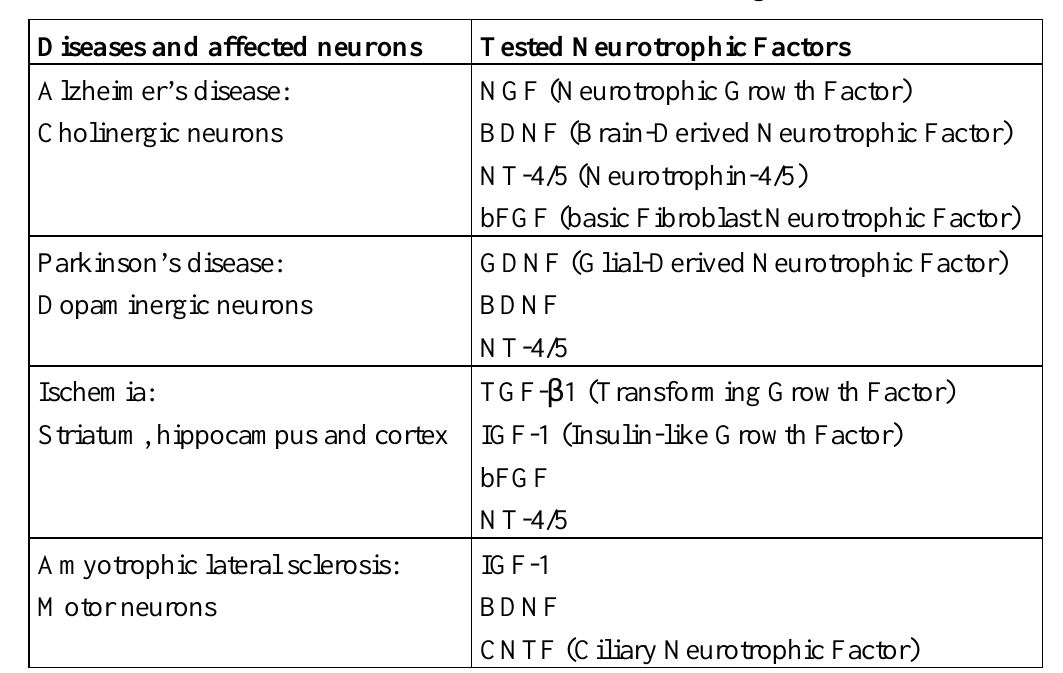
Table 1. Use of natural NFs in the treatment of neurodegenerative